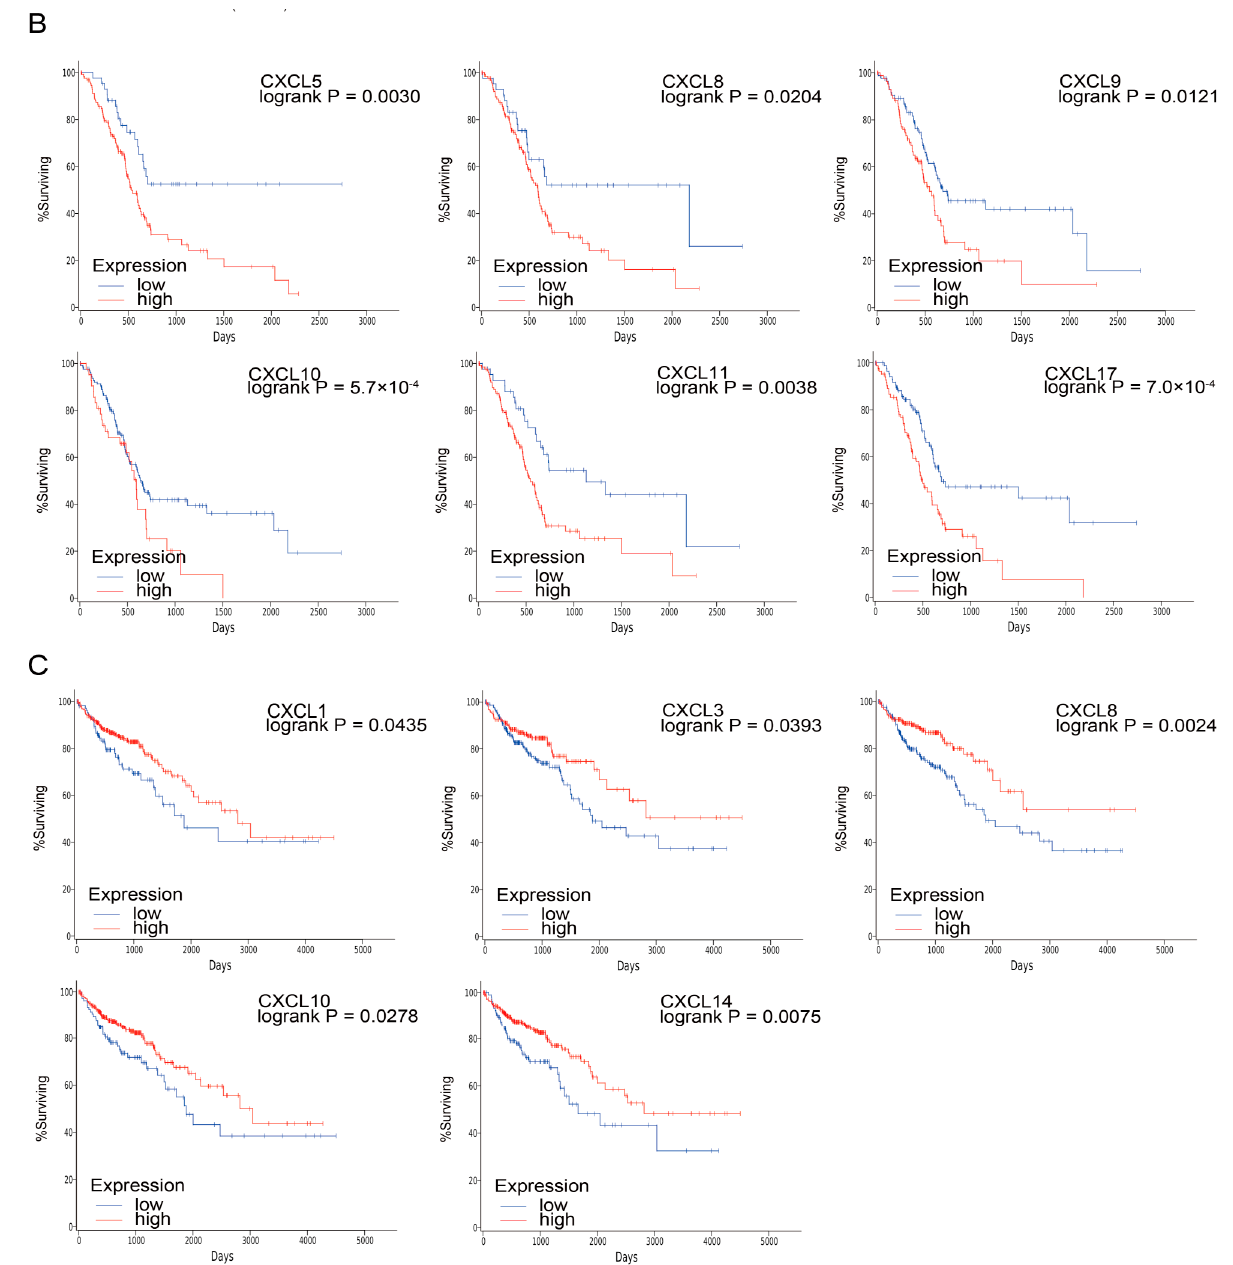
Figure 7. The prognostic value of mRNA level of CXCs in BRCA (Kaplan–Meier plotter) ( A ), COAD ( B ), and PDAC ( C ) patients (OncoLnc).